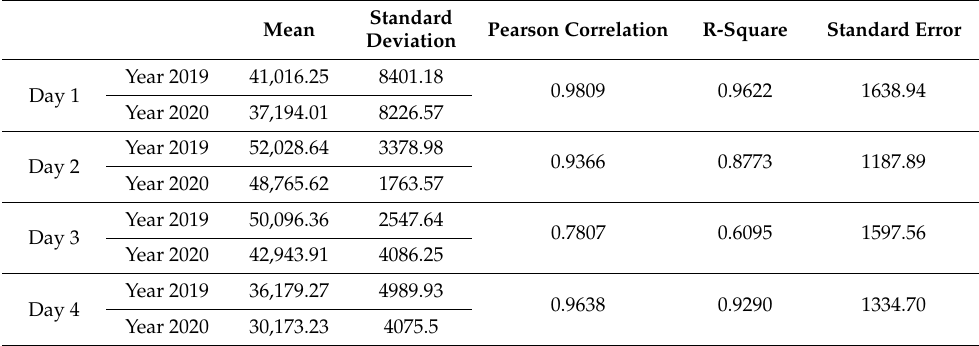
Table 1. The statistical analysis of the 2019 and 2020 Hengchun Township’s estimated population from mobile communications data on each